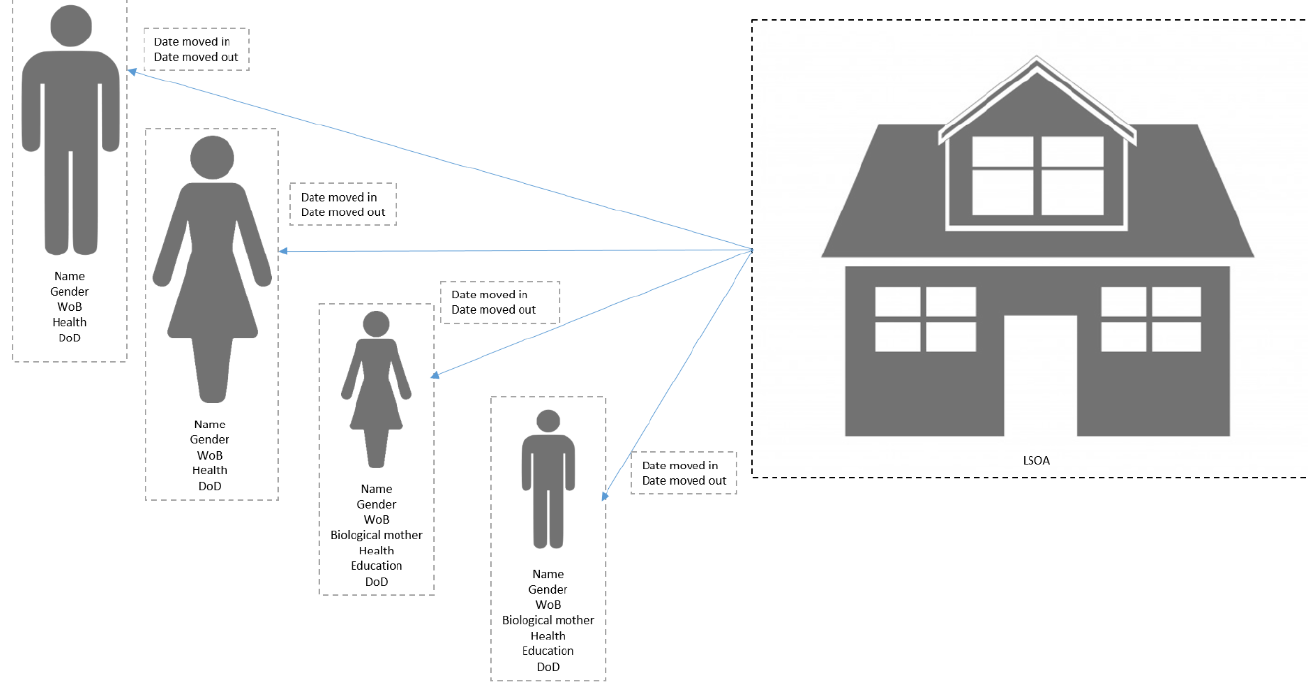
Figure 1: Data variables which can be used to identify people living at the same